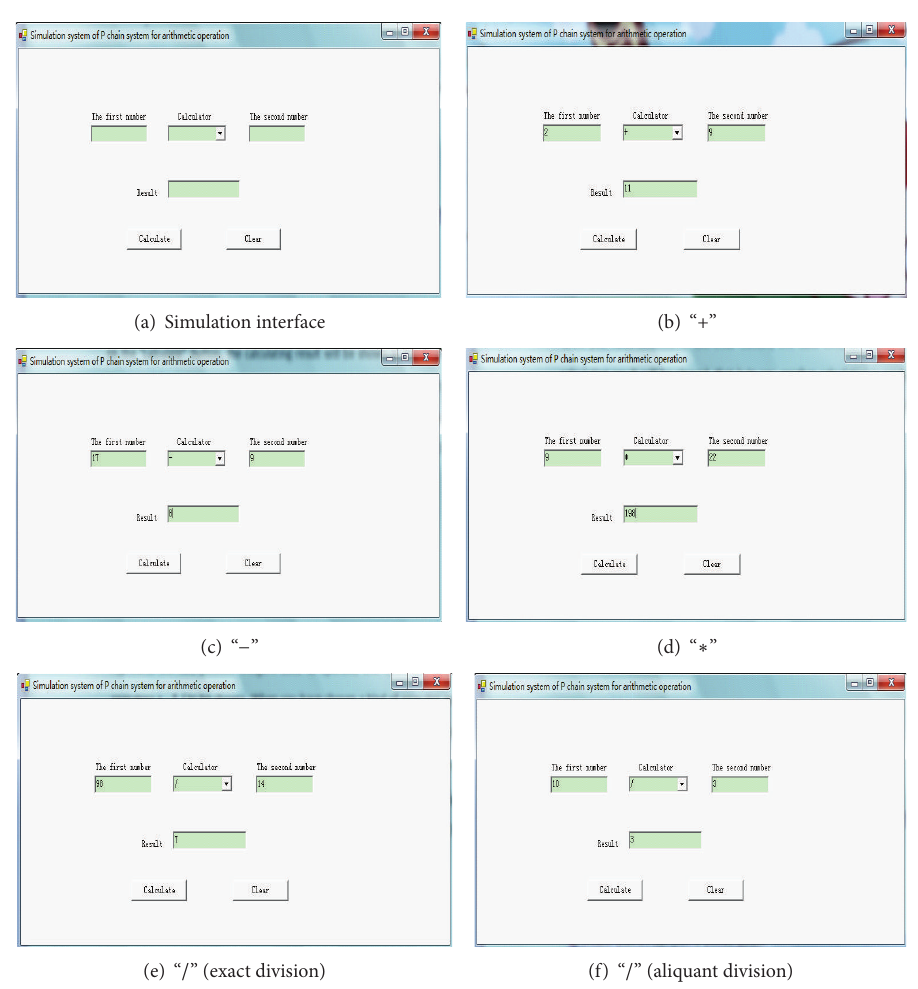
Figure 6: Simulation interface of P chain system for arithmetic